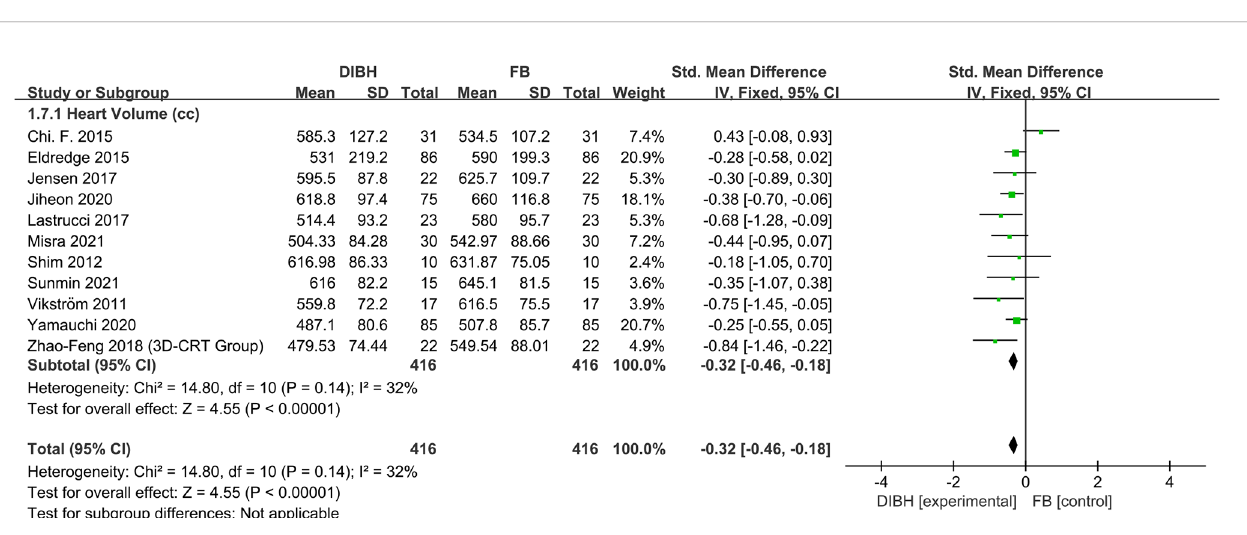
FIGURE 8 | Forest plot of heart volume between the DIBH group and FB group.